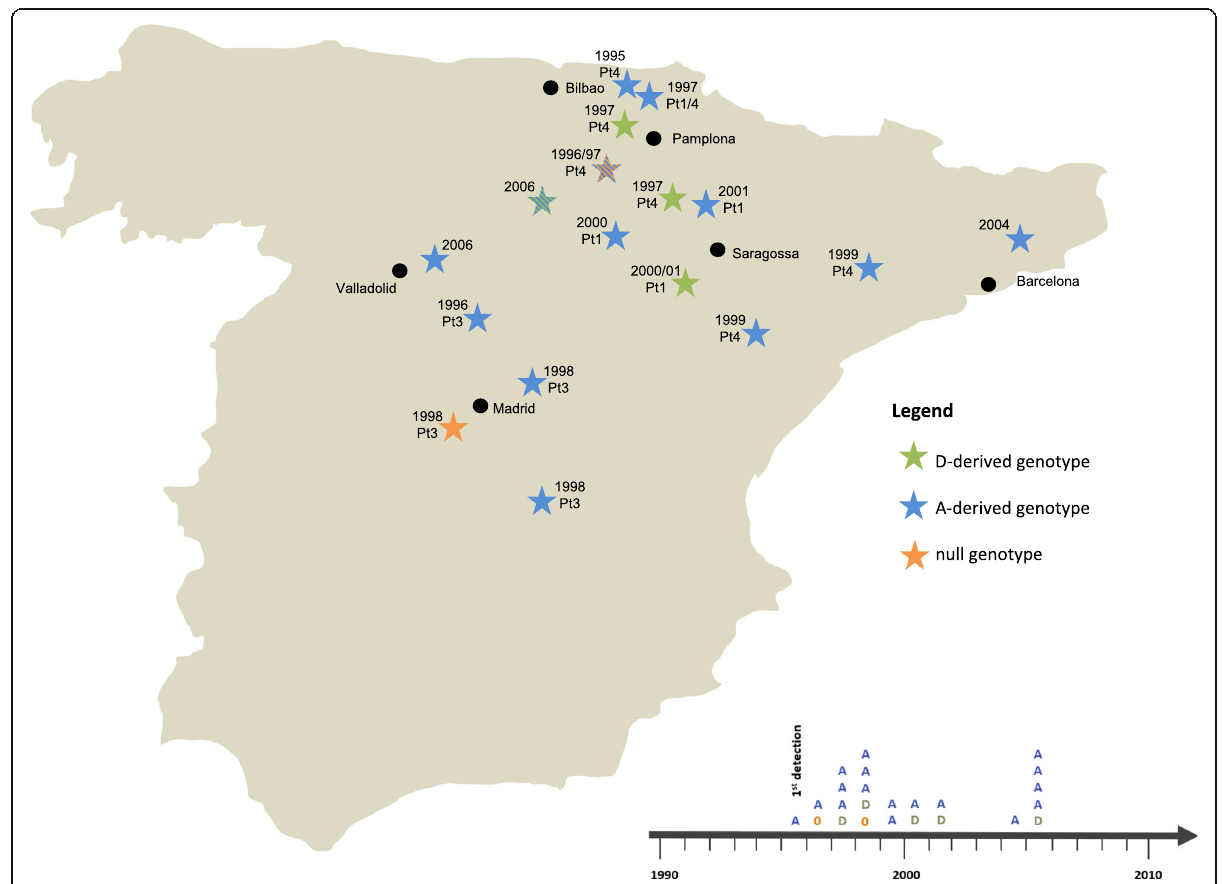
Fig. 7 Geographical distribution and timeline of the appearance of A- and D-derived genotypes in Spain in the timeframe 1995 – 2006. Striped stars indicate the presence of two genotypes in one geographical location. The null PCR genotype (labelled as 0 in the timeline) is indicated in red. Wherever available results of PFGE characterization on the same isolates were added for comparison (Jock et al. 2002; Donat et al.